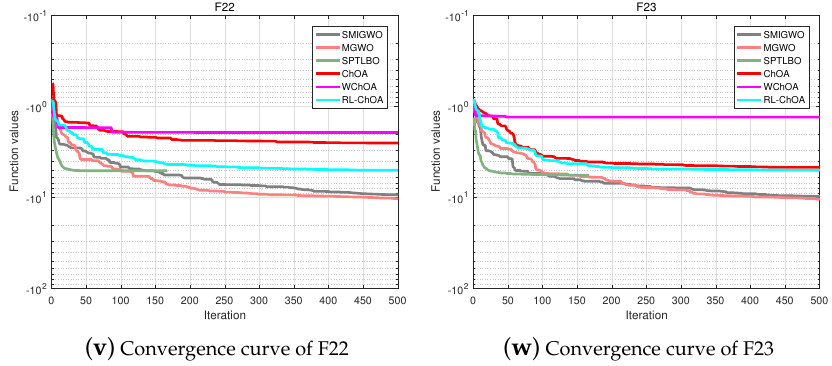
Figure 6. Convergence figures on test functions F 1– F